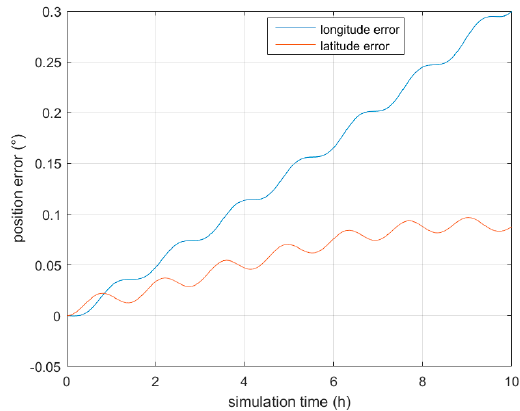
Figure 2. The INS position error.